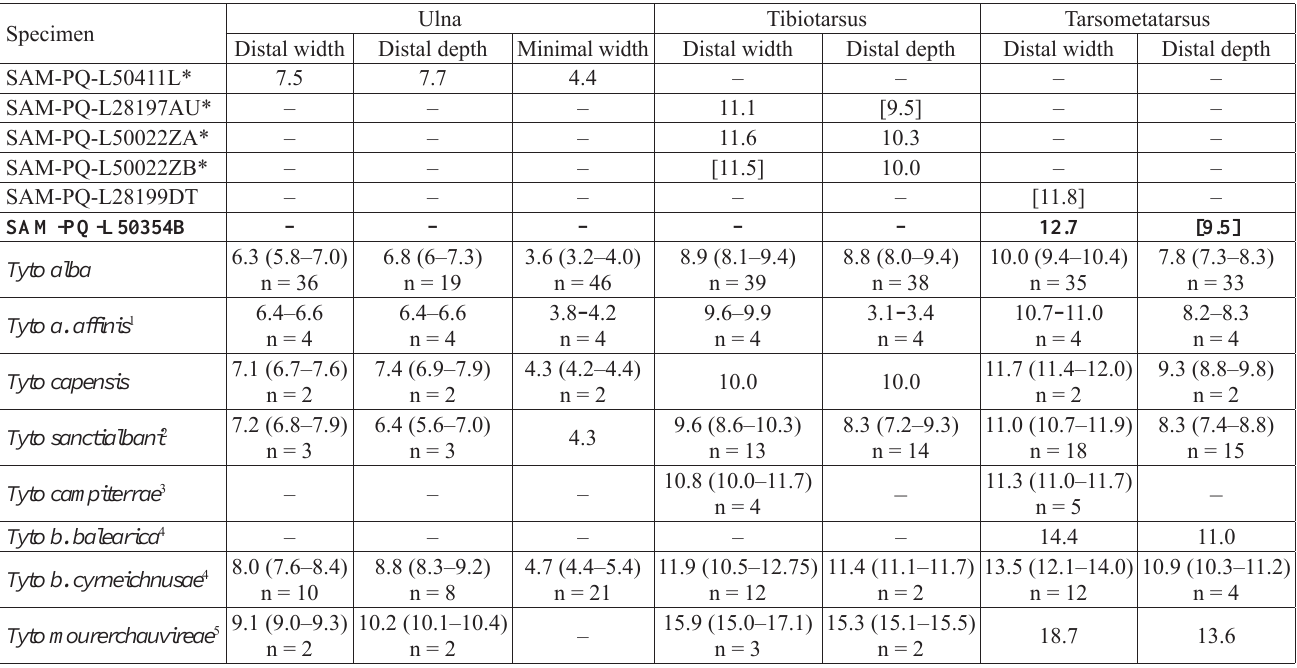
Table 2. Measurements (in mm) of ulna, tibiotarsus, and tarsometatarsus of Tyto richae sp. nov. from Langebaanweg in comparison to corre- sponding measurements of extant T. alba and fossil Tyto species. Measurements of slightly worn or damaged bones are given in square brackets. The holotype is highlighted in bold, paratypes are indicated by an asterisk; 1 measurements after Brodkorb and Mourer-Chauviré (1984); 2 mea- surements after Pavia and Mourer-Chauviré (2011); 3 measurements after Jánossy (1991); 4 measurements after Louchart (2002); 5 measurements after Pavia (2004); n, sample